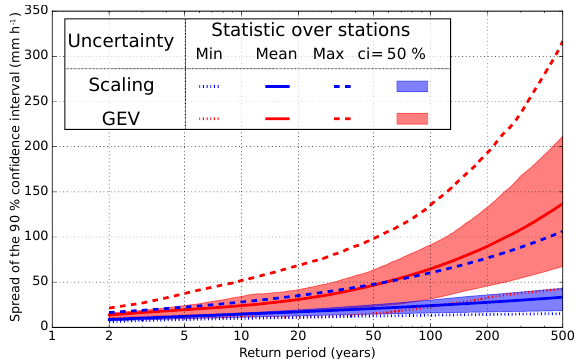
Figure 9. Evolution of the spread of the 90% confidence interval of return levels depending on the return period. The red color of the spread is due to the uncertainty of GEV(24h) fitting, while the blue color of the spread is due to the uncertainty of the scaling. Results for all stations have been combined. The mean, min, max, and 50% confidence interval of the spread obtained at the different stations are also